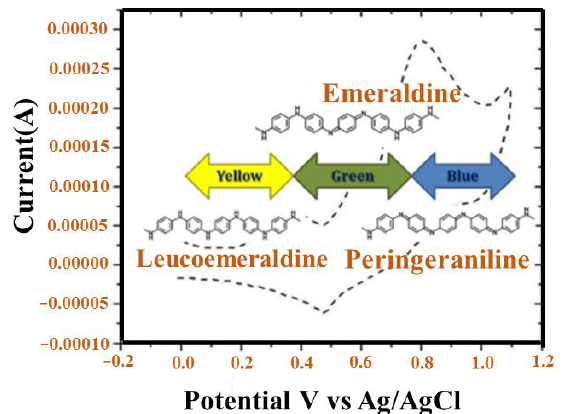
Figure 22. PANI in place of smart glass with oxidation/reduction states. Reprinted from Fundamentals and Emerging Applications of Polyaniline, Zarrintaj, P.; Vahabi, H.; Saeb, M.R.; Mozafari, M, Application of polyaniline and its derivatives, pp. 259 – 272., Copyright (2019), with permission from Elsevier.